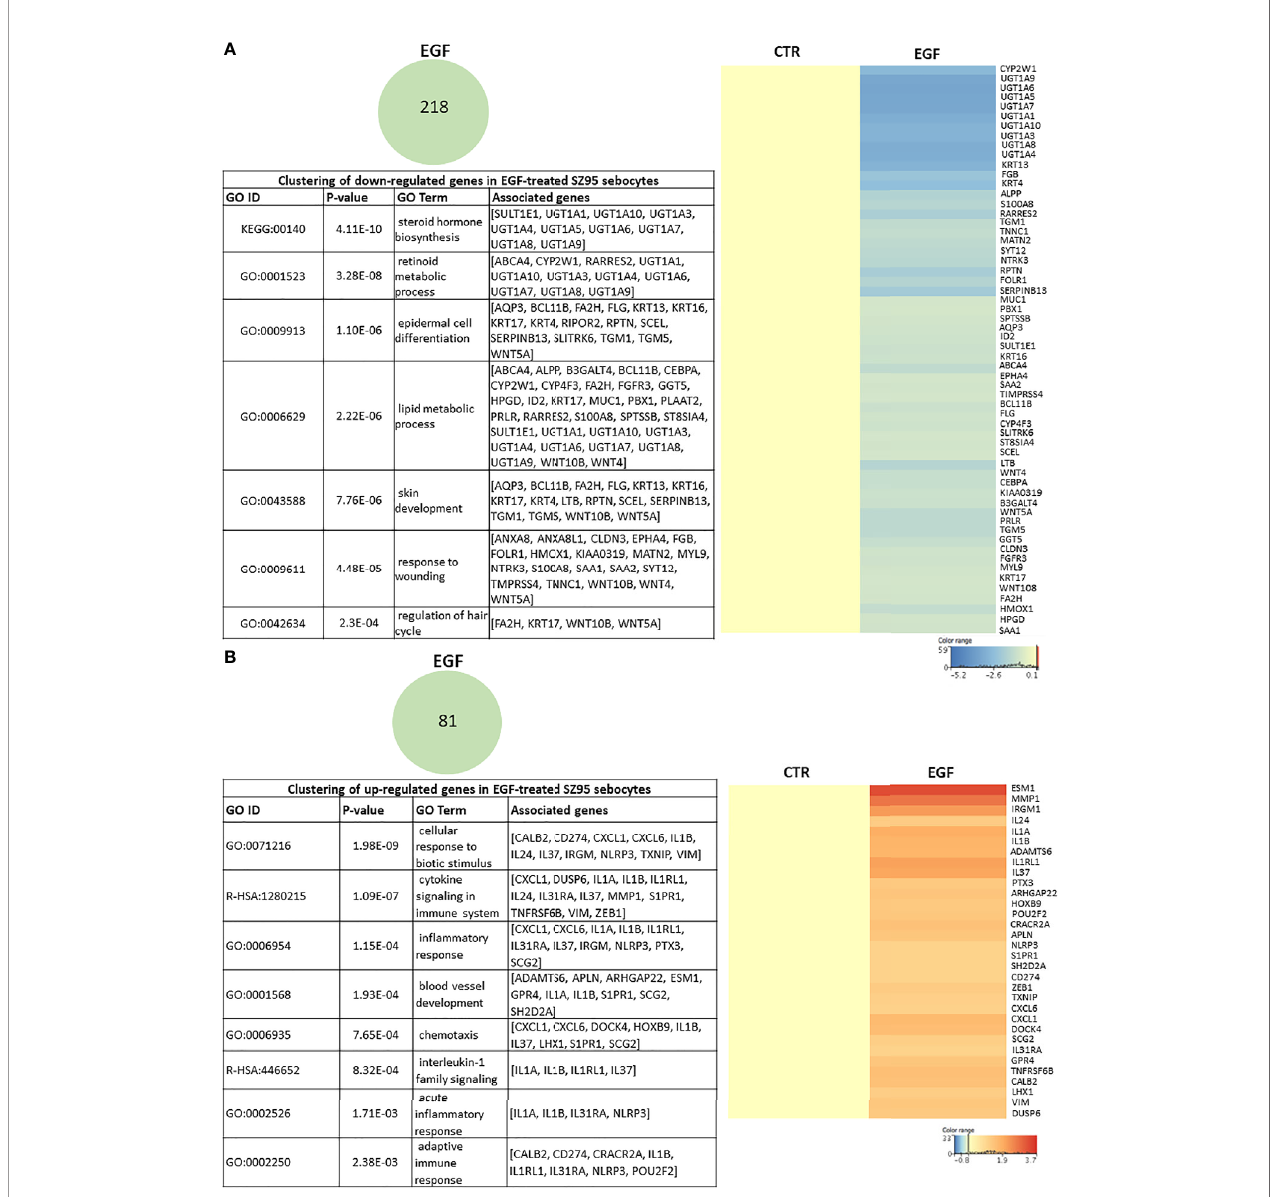
FIGURE 2 | EGF-induced transcriptional changes in SZ95 sebocytes. SZ95 sebocytes were cultured in the presence or absence of EGF. Samples for RNA-seq measurements were harvested at 72 hours of culturing, processed and measured as described in Materials and Methods. (A) The 218 transcripts that were signi fi cantly down-regulated in SZ95 sebocytes cultured in the presence of EGF (EGF) when compared to cells cultured in the absence of EGF (CTR) were clustered into the groups of steroid hormone biosynthesis, lipid metabolic process, skin development and response to wounding. Heat map display of the down-regulated transcripts contributing to the clusters. Differentially expressed genes were normalized to control and results are expressed as average mean of three samples from subcultures of SZ95 sebocytes. Color intensities re fl ect the ratios of signal intensities. (B) The 81 transcripts that were signi fi cantly up-regulated in SZ95 sebocytes cultured in the presence of EGF (EGF) when compared to cells cultured in the absence of EGF (CTR), were clustered into the groups of IL1 signaling, blood vessel development and in fl ammatory responses. Heat map display of the up-regulated transcripts contributing to the clusters. Differentially expressed genes were normalized to control and results are expressed as average mean of three samples from subcultures of SZ95 sebocytes. Color intensities re fl ect the ratios of signal intensities as